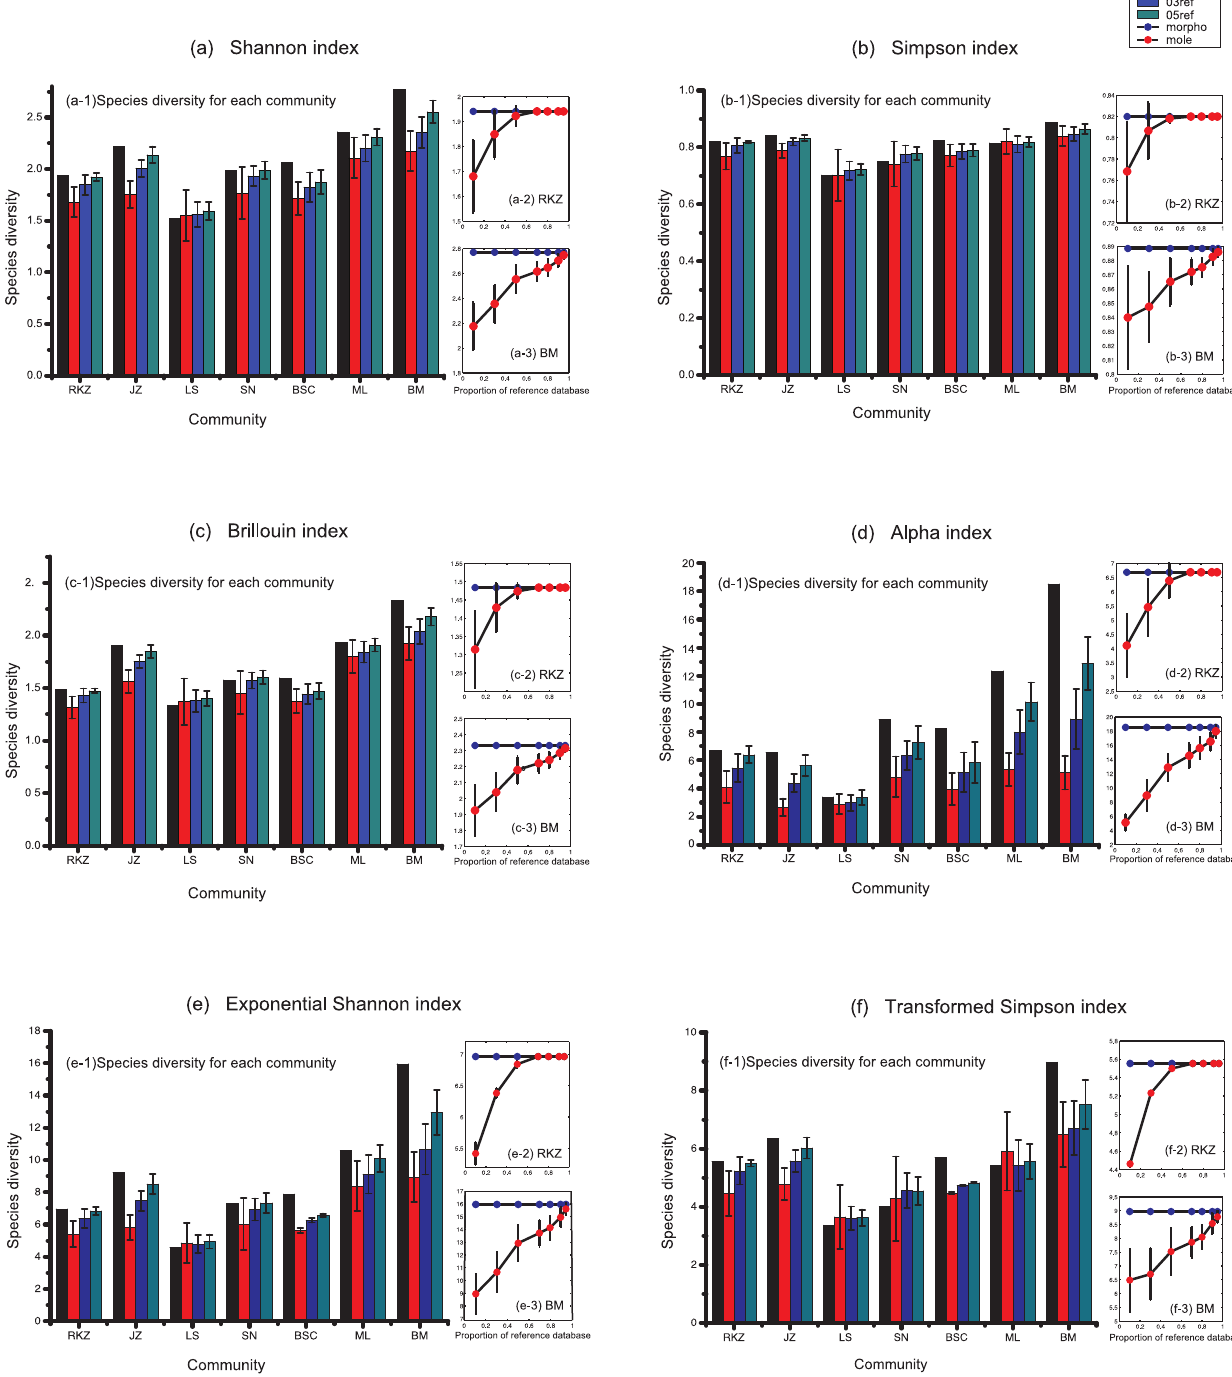
Figure 2. Species diversities of Tibetan moth species (Noctuidae) for each community, calculated using different diversity indices. (a) Shannon index; (b) Simpson index; (c) Brillouin index; (d) a index; (e) Exponential Shannon index; (f) Transformed Simpson index.